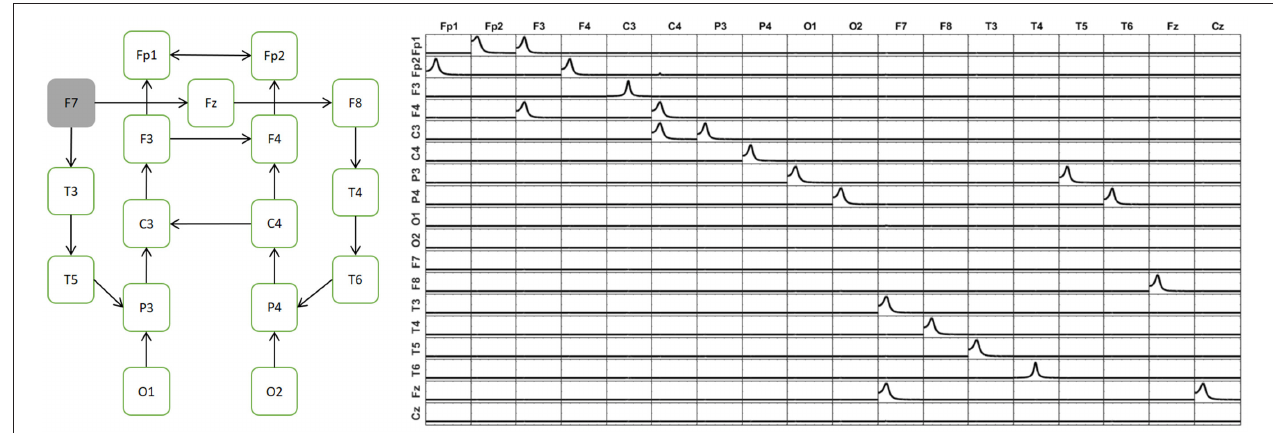
FIGURE 6 | Simulation of a system with 17 variables. The diagram in the left panel shows the map of connectivity patterns simulated among the sources. The right panel shows the reconstruction of the connectivity patterns among the signals, using iCoh. Note that the reconstruction is exact.